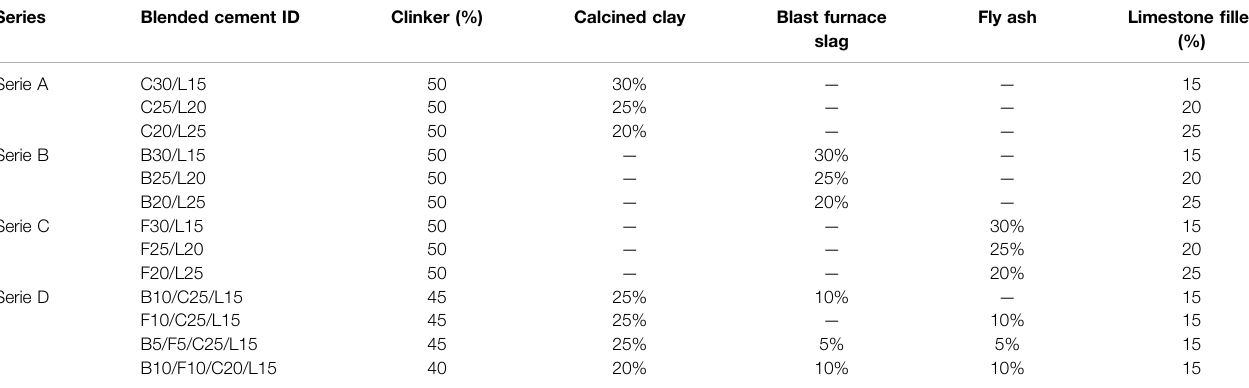
TABLE 2 | Proportions of constituents used in the blended cements (% by mass). All cements contain 5% gypsum.